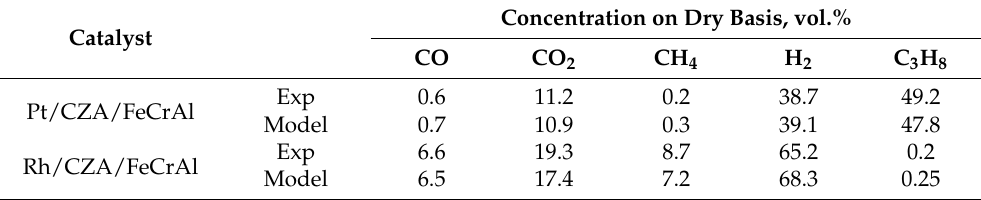
Concentration on Dry Basis, vol.%